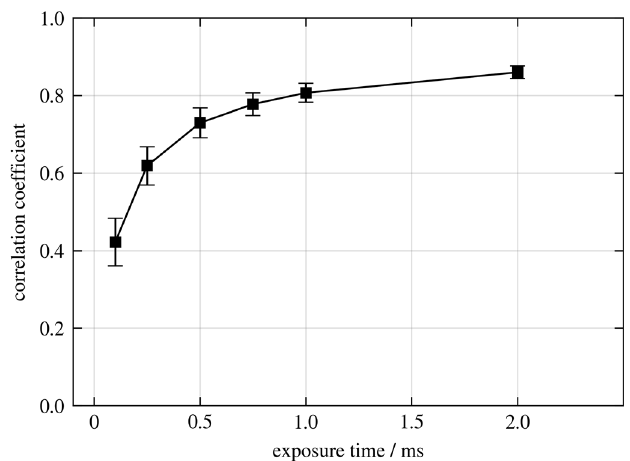
Figure 13. Normalized cross-correlation between simultaneously acquired distributions of OH* and CH* in a turbulent methane/air diffusion flame (compare Figure 12) as a function of image exposure time.